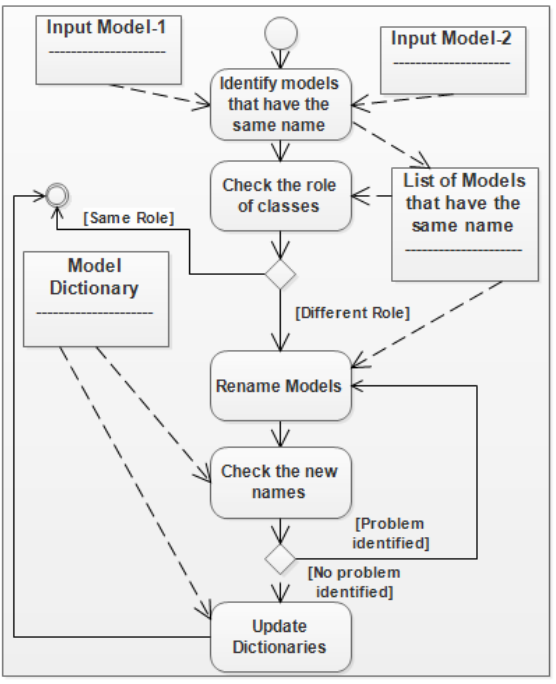
Fig. 3. A graphical concept of the composition conflict